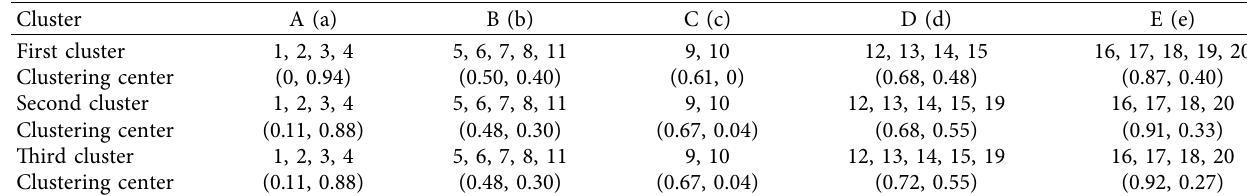
Table 5: Results for each clustering step.